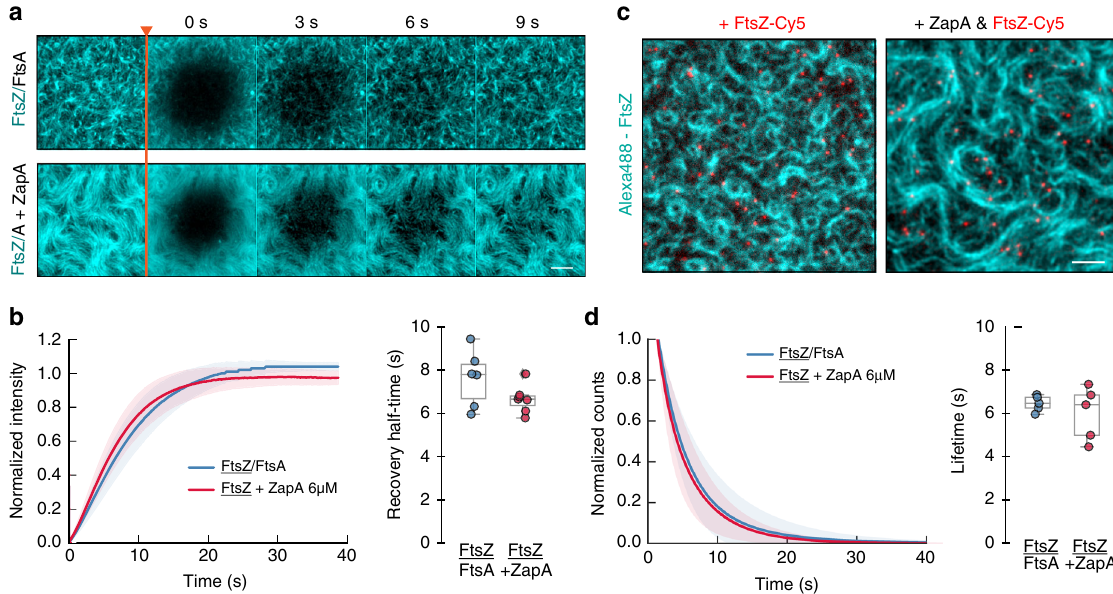
Fig. 6 ZapA does not change length of FtsZ fi laments. a Snapshots showing fl uorescence recover after photobleaching (FRAP) experiments for FtsZ fi laments without (upper panel) and in the presence (lower panel) of 6 μ M ZapA. b Half-time recovery of FtsZ was not affected by the addition of ZapA (7.63 ± 1.30 and 6.66 ± 0.64 s, respectively). c Snapshot from single molecule tracking experiments of FtsZ (red) with and without 6 μ M ZapA. Scale bars, 5 μ m d Lifetime distribution of FtsZ does not change signi fi cantly with ZapA (FtsZ = 6.59 ± 0.28 s, blue, n = 5; FtsZ with ZapA = 6.01 ± 1.24 s, red, n = 6). Source data available at Figshare [https://doi.org/10.6084/m9. fi gshare.10347062.v1].